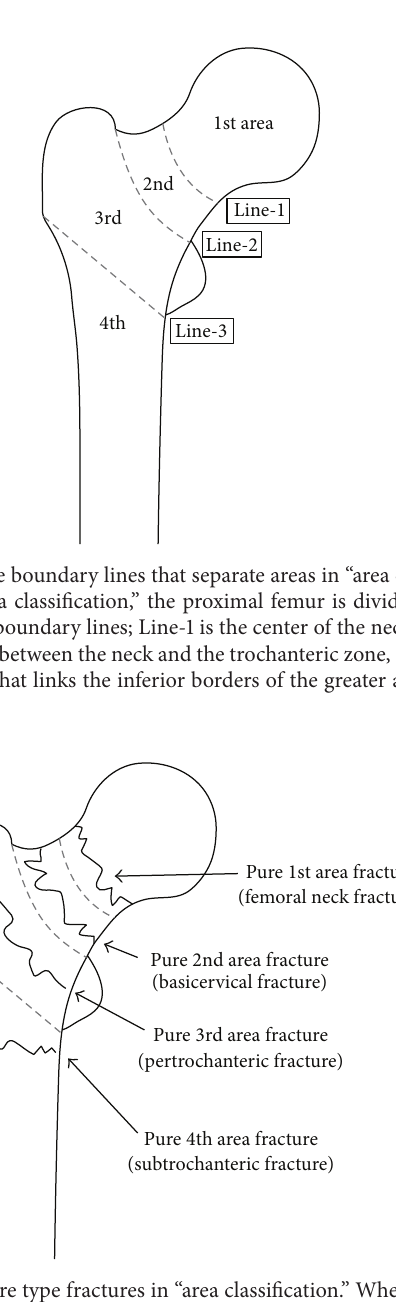
Figure 2: Pure type fractures in “area classification.” When there is a fracture in only the first area, the fracture is classified as a pure first area fracture, and so on. Thus, pure 1 type is the so-called neck fracture, pure2 typeistheso-called basicervical fracture,pure3type is the so-called trochanteric fracture, and pure 4 type is the so-called subtrochanteric